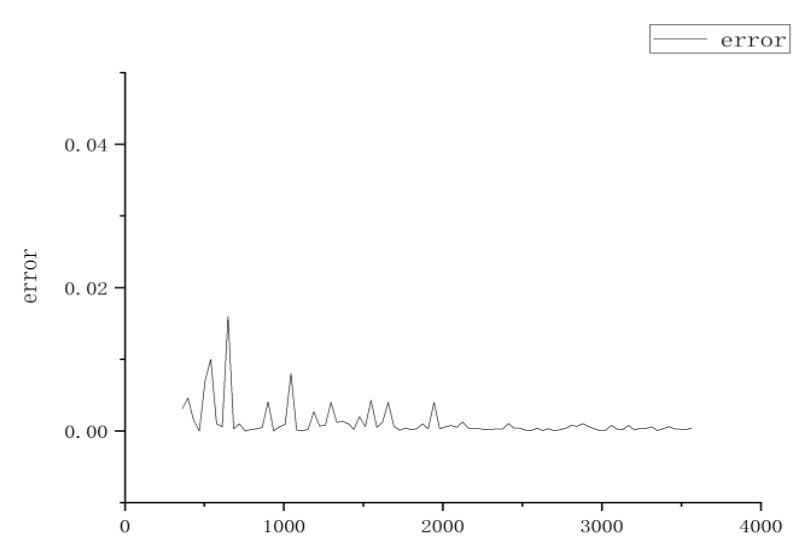
Figure 23. Error between the actual value and predicted values.